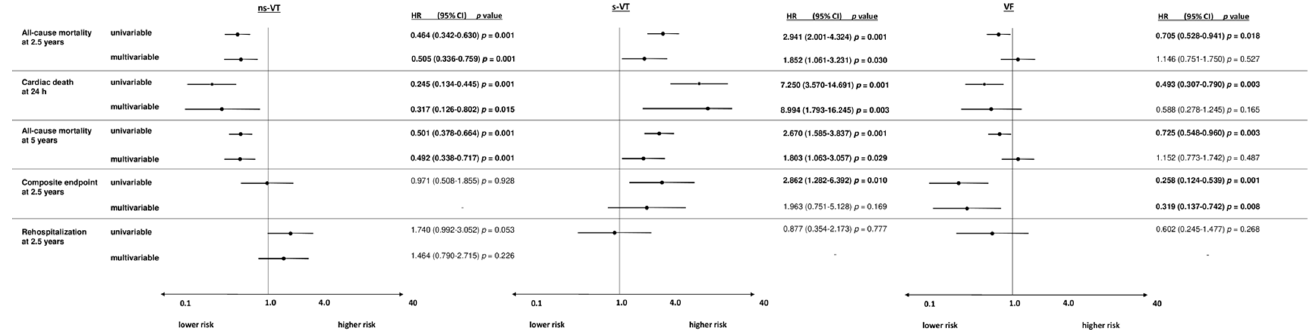
Figure 3. Forest plots demonstrating the uni- and multivariable hazard ratios (HR) with 95% confi- dence intervals (CI) for the primary endpoint all-cause mortality at 2.5 years, as well as for secondary endpoints all-cause mortality at 24 h, all-cause mortality at 5 years, the composite arrhythmic end- point (i.e., recurrent ventricular tachyarrhythmias, appropriate ICD therapies) at 2.5 years and cardiac rehospitalization at 2.5 years in AMI patients. Multivariable models were adjusted for age, sex, diabetes, chronic kidney disease, LVEF < 35%, COPD, the presence of a prior AMI, CABG and the presence of a CTO. HRs with corresponding 95% CI were calculated for the comparisons of patients with VF compared to s-VT, s-VT versus ns-VT and ns-VT versus s-VT and VF.